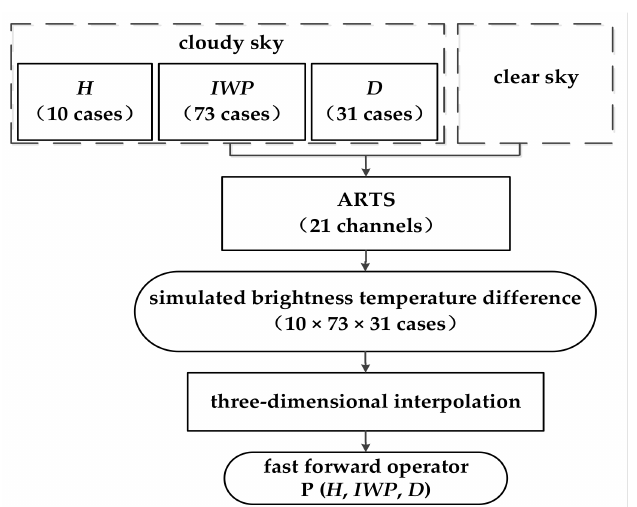
Figure 2. Construction process of the fast forward operator. H is cloud height, IWP is the ice water path, and D is the effective particle diameter. ARTS is the atmospheric radiative transfer simulator, and P is the fast forward